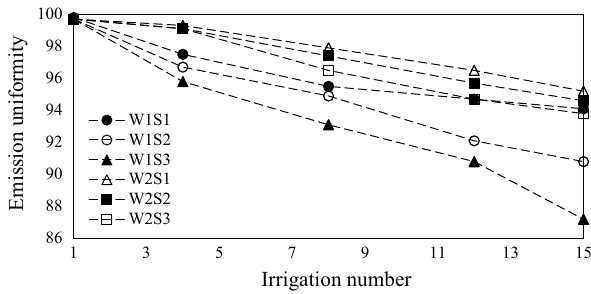
Fig. 4 Variations of emission uniformity during the experiment